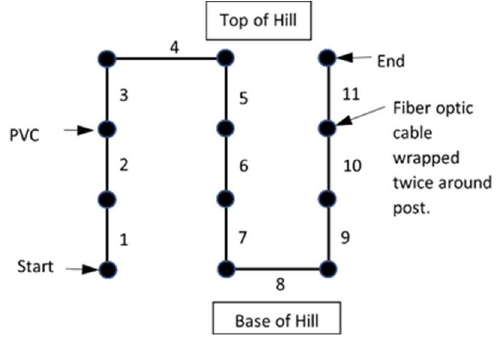
Figure 6. Arrangement of DSS Cable and Posts.